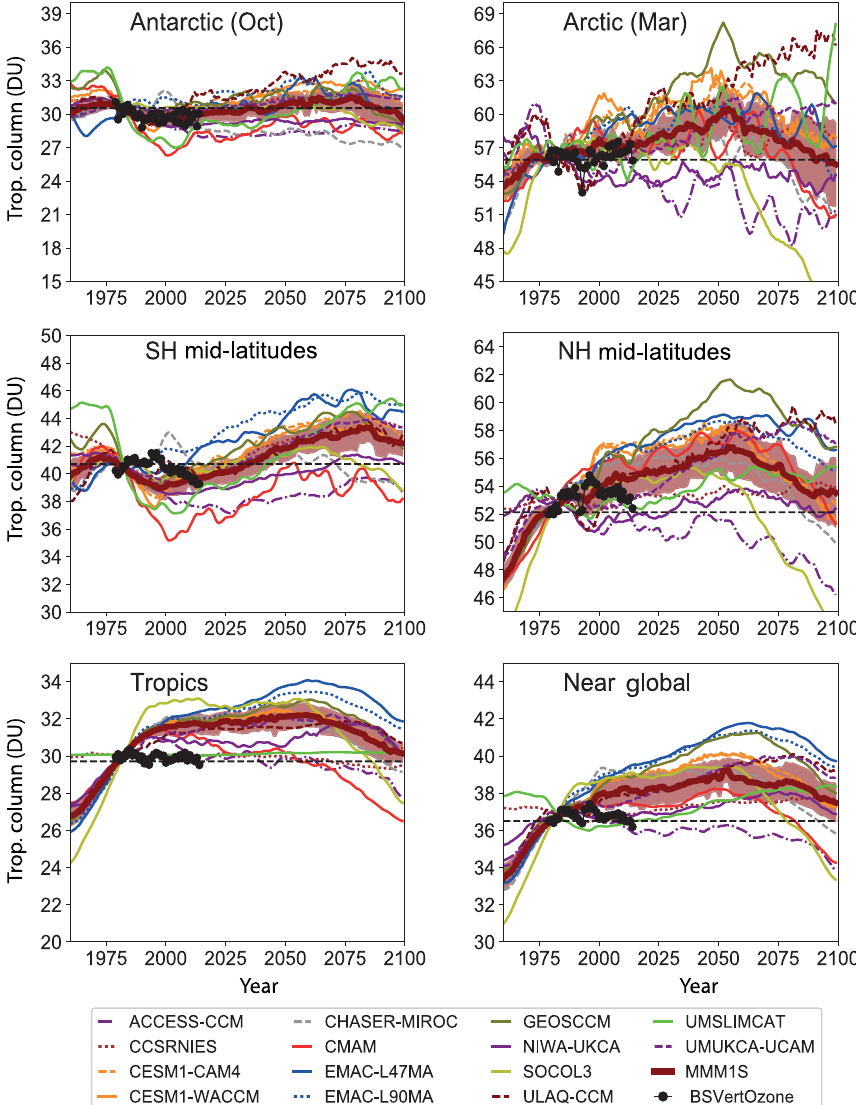
Figure 9. Evolution of tropospheric partial column ozone (DU) (surface–tropopause) from 14 individual models and the MMM1S for the REF-C2 simulations. Also shown is the tropospheric partial column ozone derived from BSVertOzone